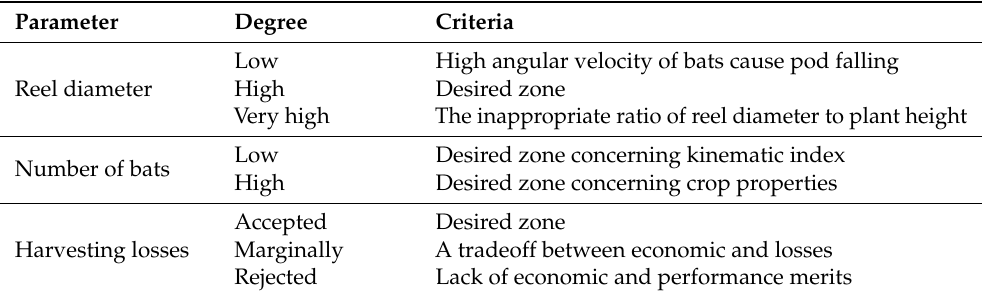
Figure 3. Fuzzy membership functions for the inputs reel diameter and number of bats, and output functions for the harvesting losses model. Table 2. Membership function definition procedure for the optimization of the reel functional oper- ators.